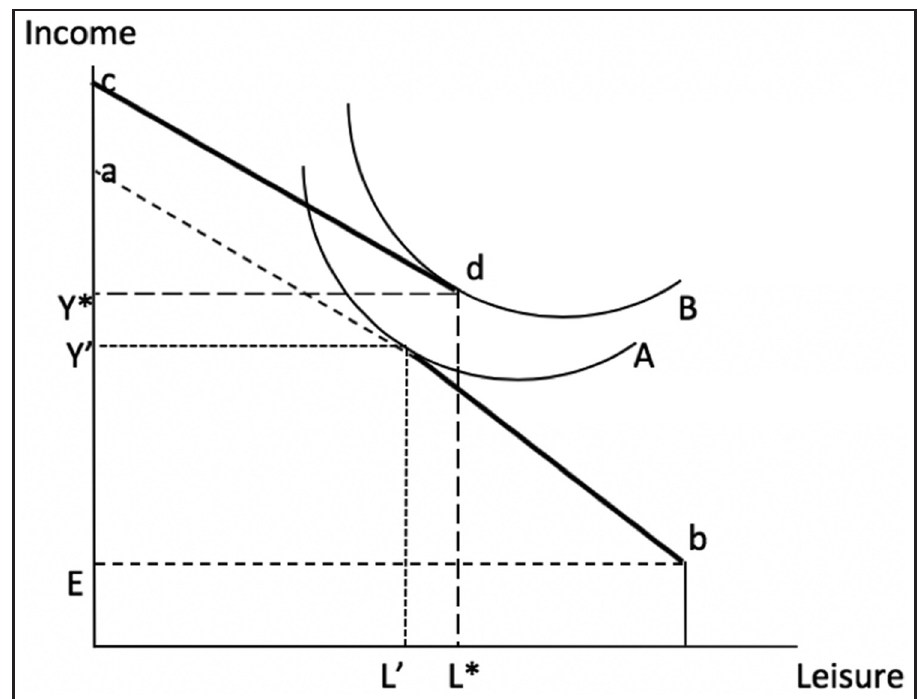
Figure 2 Predicted effect of maternal labor supply pre